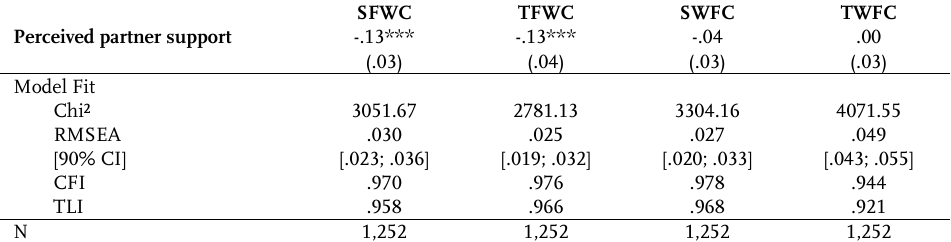
Table 3 : Standardized effects and model fits of social support on strain and time-related conflicts SFWC TFWC